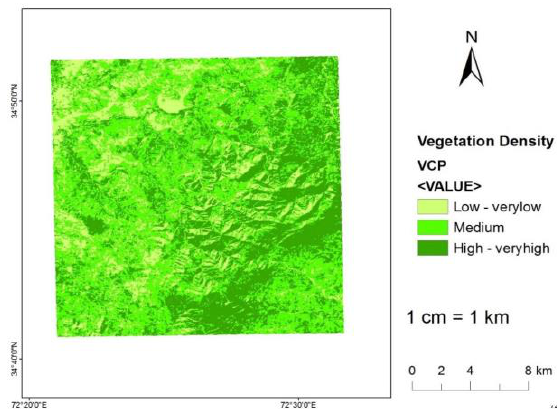
Figure 7: Distribution of vegetation cover based on VCP in